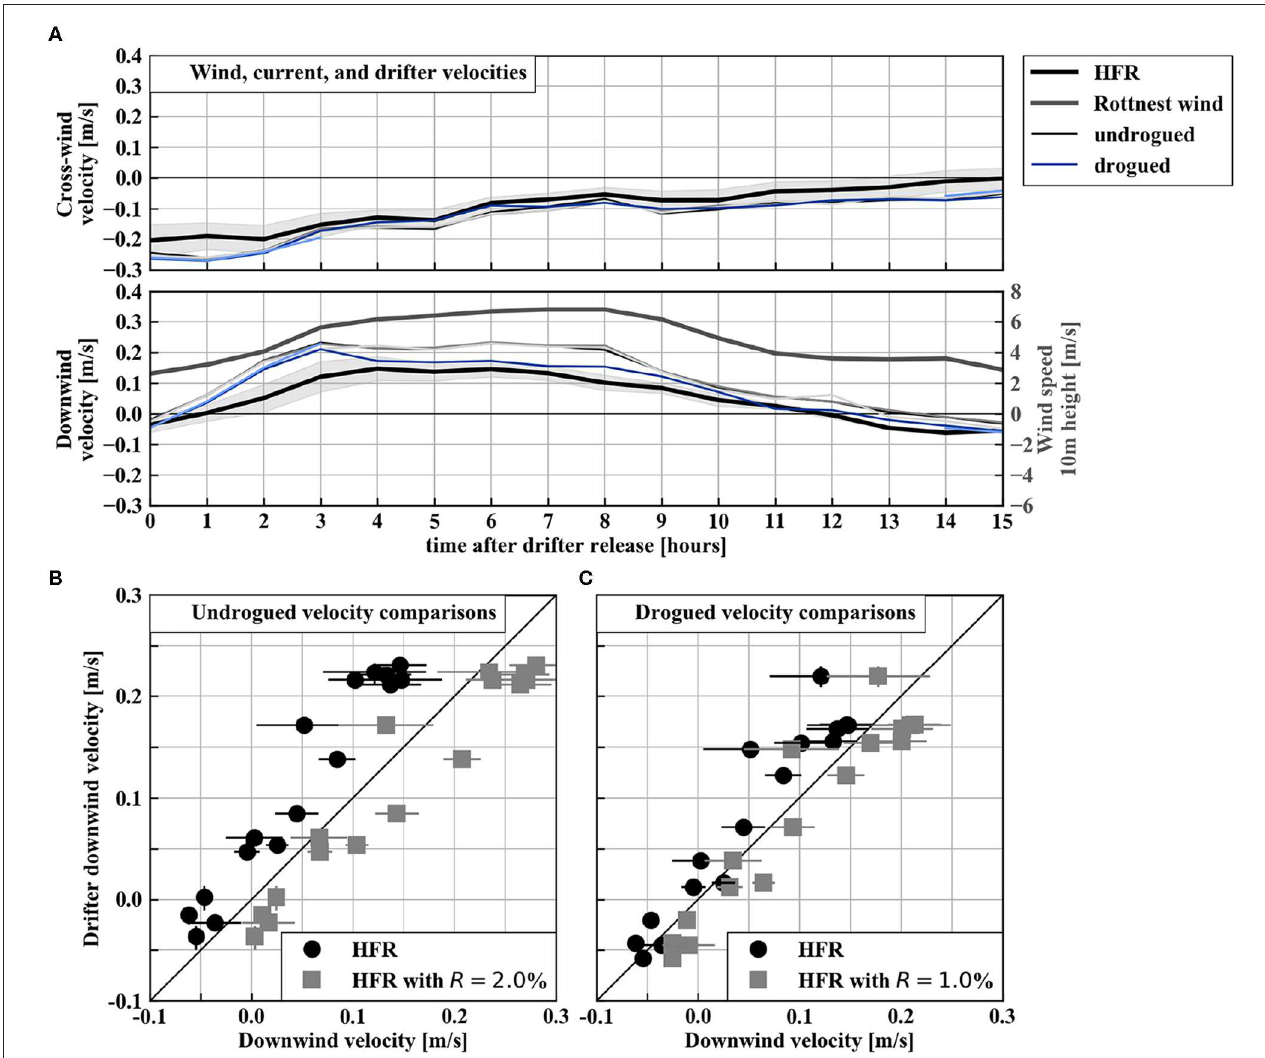
FIGURE 3 | (A) Cross- and downwind components of: HFR measured velocity along the mean drifter track (shading shows HFR velocities plus and minus one standard deviation); measured wind speed at the Bureau of Meteorology (BoM) Rottnest wind station converted to a reference 10-m height; and velocities of three undrogued and two drogued drifters. (B) Downwind component comparisons of mean undrogued drifter velocities; uncorrected HFR measured currents; and HFR corrected currents with a drift factor of R = 0.02. (C) Downwind component comparisons of mean drogued drifter velocities; uncorrected HFR measured currents; and HFR corrected currents with a drift factor of R = 0.01. Horizontal bars in (B,C) show HFR velocity plus and minus one standard deviation. Vertical bars in (B,C) show minimum and maximum drifter velocities (where applicable).